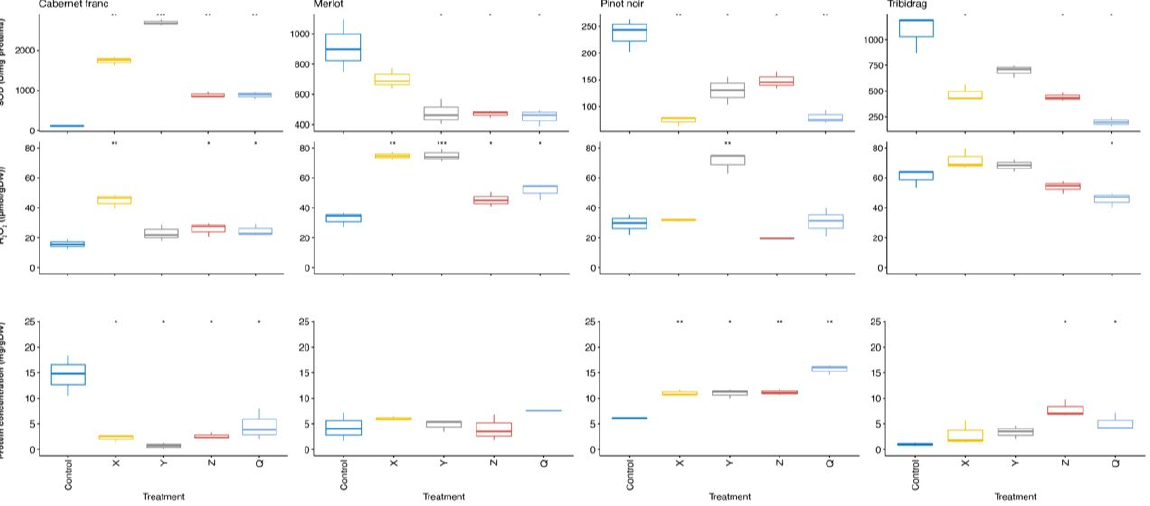
Figure 6. Differences in superoxide dismutase (SOD), hydrogen peroxide (H 2 O 2 ), and proteins caused by wild-type (WT) genotypes in 2021 in relation to control plants in ‘Cabernet Franc,’ ‘Merlot,’ ‘Pinot Noir’ and ‘Tribidrag’ grapevine varieties as analyzed by t -test. Significant differences are indicated with asterisks as follows: ‘*’indicates p < 0.05, ‘**’ indicates p < 0.01 and ‘***’ indicates p < 0.001.